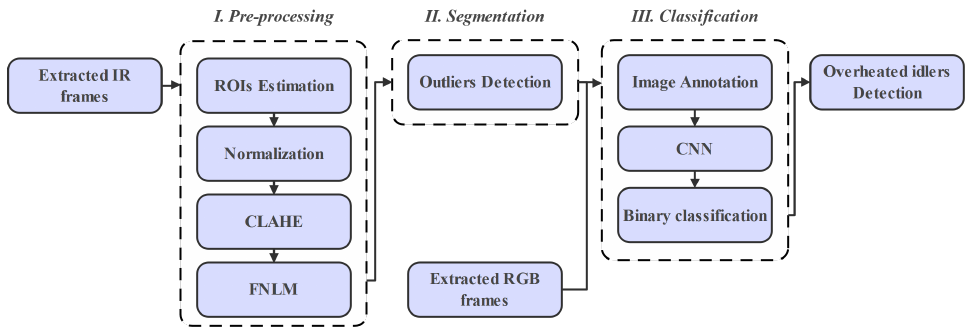
Figure 1. The proposed procedure